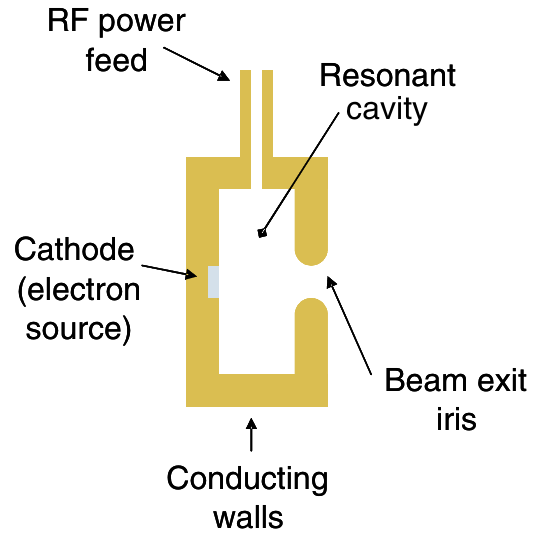
FIG. 1. (Color) Schematic of a single-cell rf electron